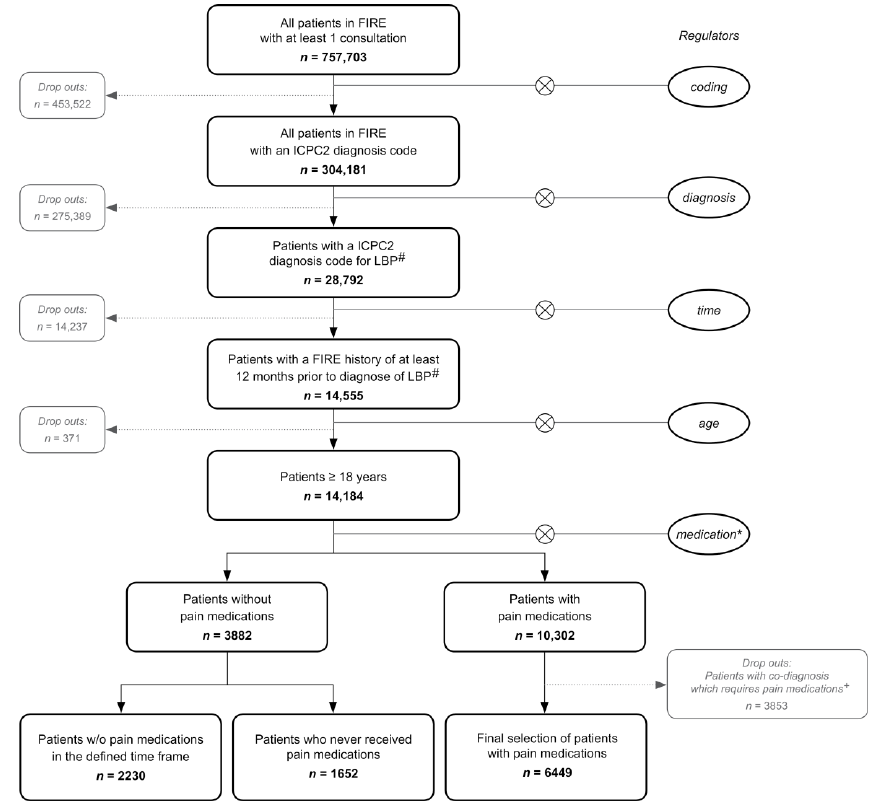
Figure 1. Flowchart. FIRE: Family medicine ICPC Research using Electronic medical records; n : number of patients; w/o: without; #: ICPC2 LBP diagnosis codes: L03, L84, L86; *: Pain medication of interest: non-steroidal anti-inflammatory drugs, paracetamol and opioids; +: Full list of all excluded ICPC2 diagnosis codes in Supplementary Material.